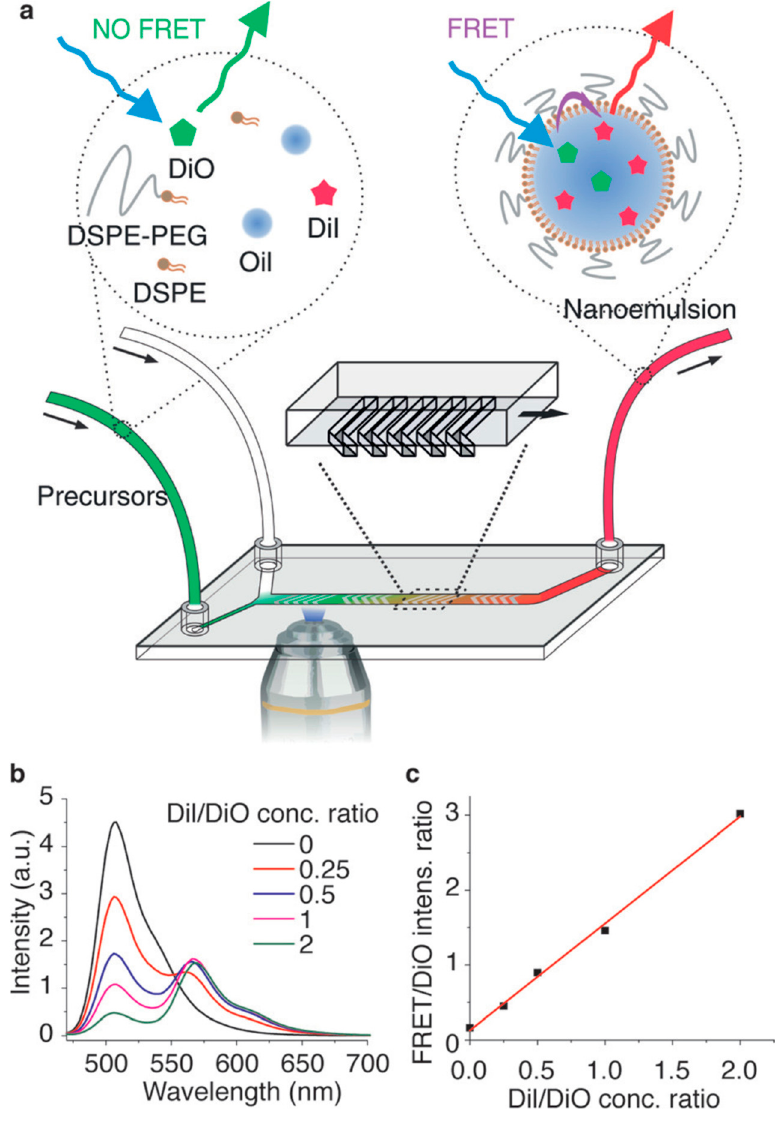
Figure 3. Real-time monitoring of nanoemulsion formation using FRET in a microfluidic device. ( a ) Schematic of the experimental setup and FRET mechanism. ( b ) Emission intensity of nanoemulsions containing different DiI/DiO concentration ratios. ( c ) Correlation between the FRET/DiO intensity ratio and the DiI/DiO concentration ratio. Reproduced with permission from ref. [25]. Copyright